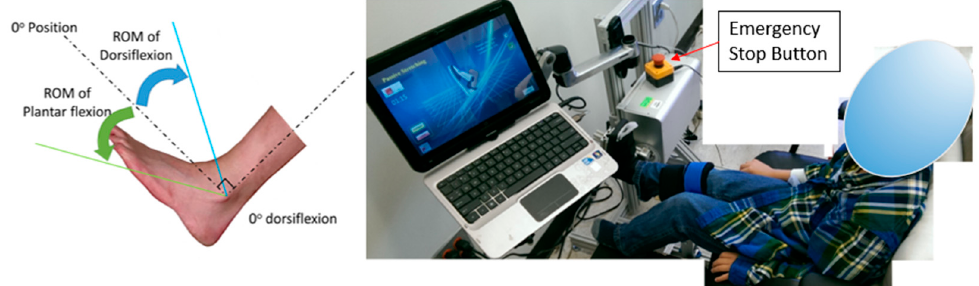
Figure 1. Range of motion (ROM) of ankle movement and definition of 0 ◦ dorsiflexion ( left ). Experimental setup ( right ) shows a child in a seated position with an extended knee and an impaired ankle strapped onto a footplate. An ankle rehabilitation robot with operated passive stretching and active movement exercise program and a computer game interface was used for training and outcome measures.